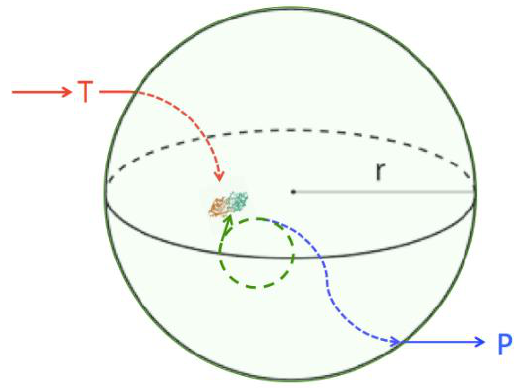
Figure 3. Schematic view of enzyme-containing nR of diameter r , with the in flux of substrate (T) and out flux of reaction product(s) (P). The enzyme concentration [ E ] is much higher than [ T ], so that either catalytic turnover or irreversible inhibition of the reactive enzyme takes place under second order.